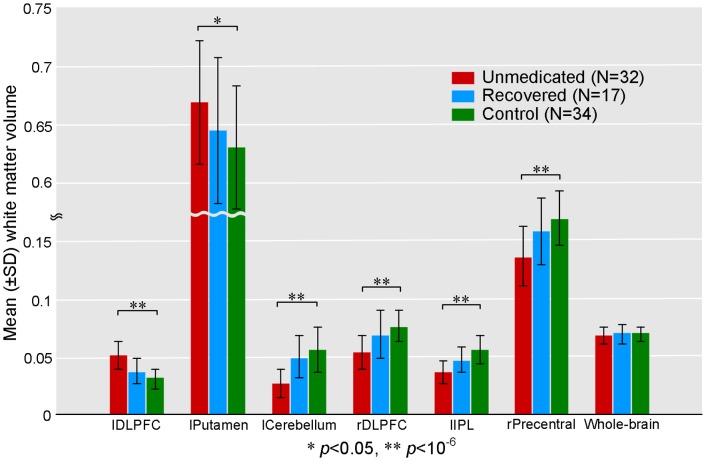
Voxel-averaged white matter volumes in the regions with significant changes in treatment-naïve depressed patients (N = 32), recovered patients (N = 17) and healthy subjects (N = 34).Two-tailed levels of significance (p<0.05, uncorrected) were used in the analyses. There were significant differences in the bilateral DLPFC, left putamen, left cerebellum posterior lobe, left inferior parietal lobule and right precentral gyrus between treatment-naïve depressed patients and healthy controls, but these differences did not remain statistically significant in the recovered patients after successful antidepressant therapy relative to the healthy group. There were no significant differences in the total white matter volume among the three groups. l/rDLPFC: left/right dorsolateral prefrontal cortex; lputamen: left putamen; lCerebellum: left cerebellum posterior lobe; lIPL: left inferior parietal lobule; rPrecentral: right precentral gyrus.